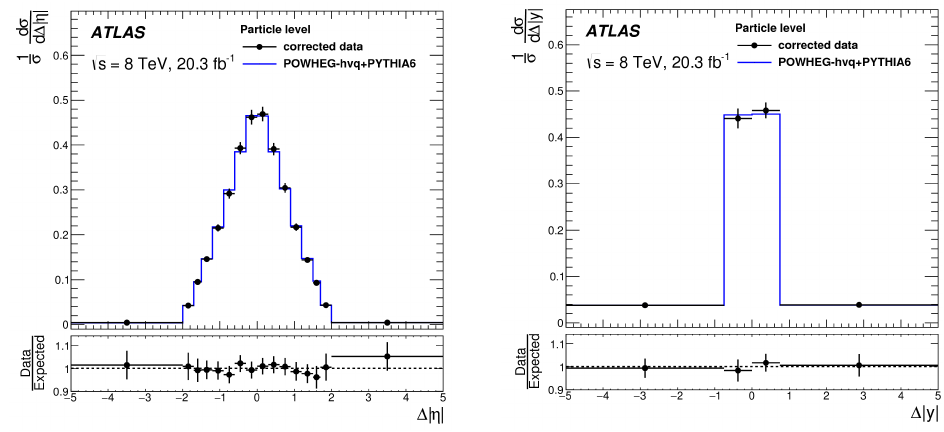
Figure 9. Summary of the differential results for the lepton asymmetry ( left ) and the t ¯ t asymmetry ( right ) in the full phase space [38]. The prediction in blue are obtained using the P OWHEG -hvq generator at NLO [42]. The inclusive result is compared to the NLO+EW prediction [14].